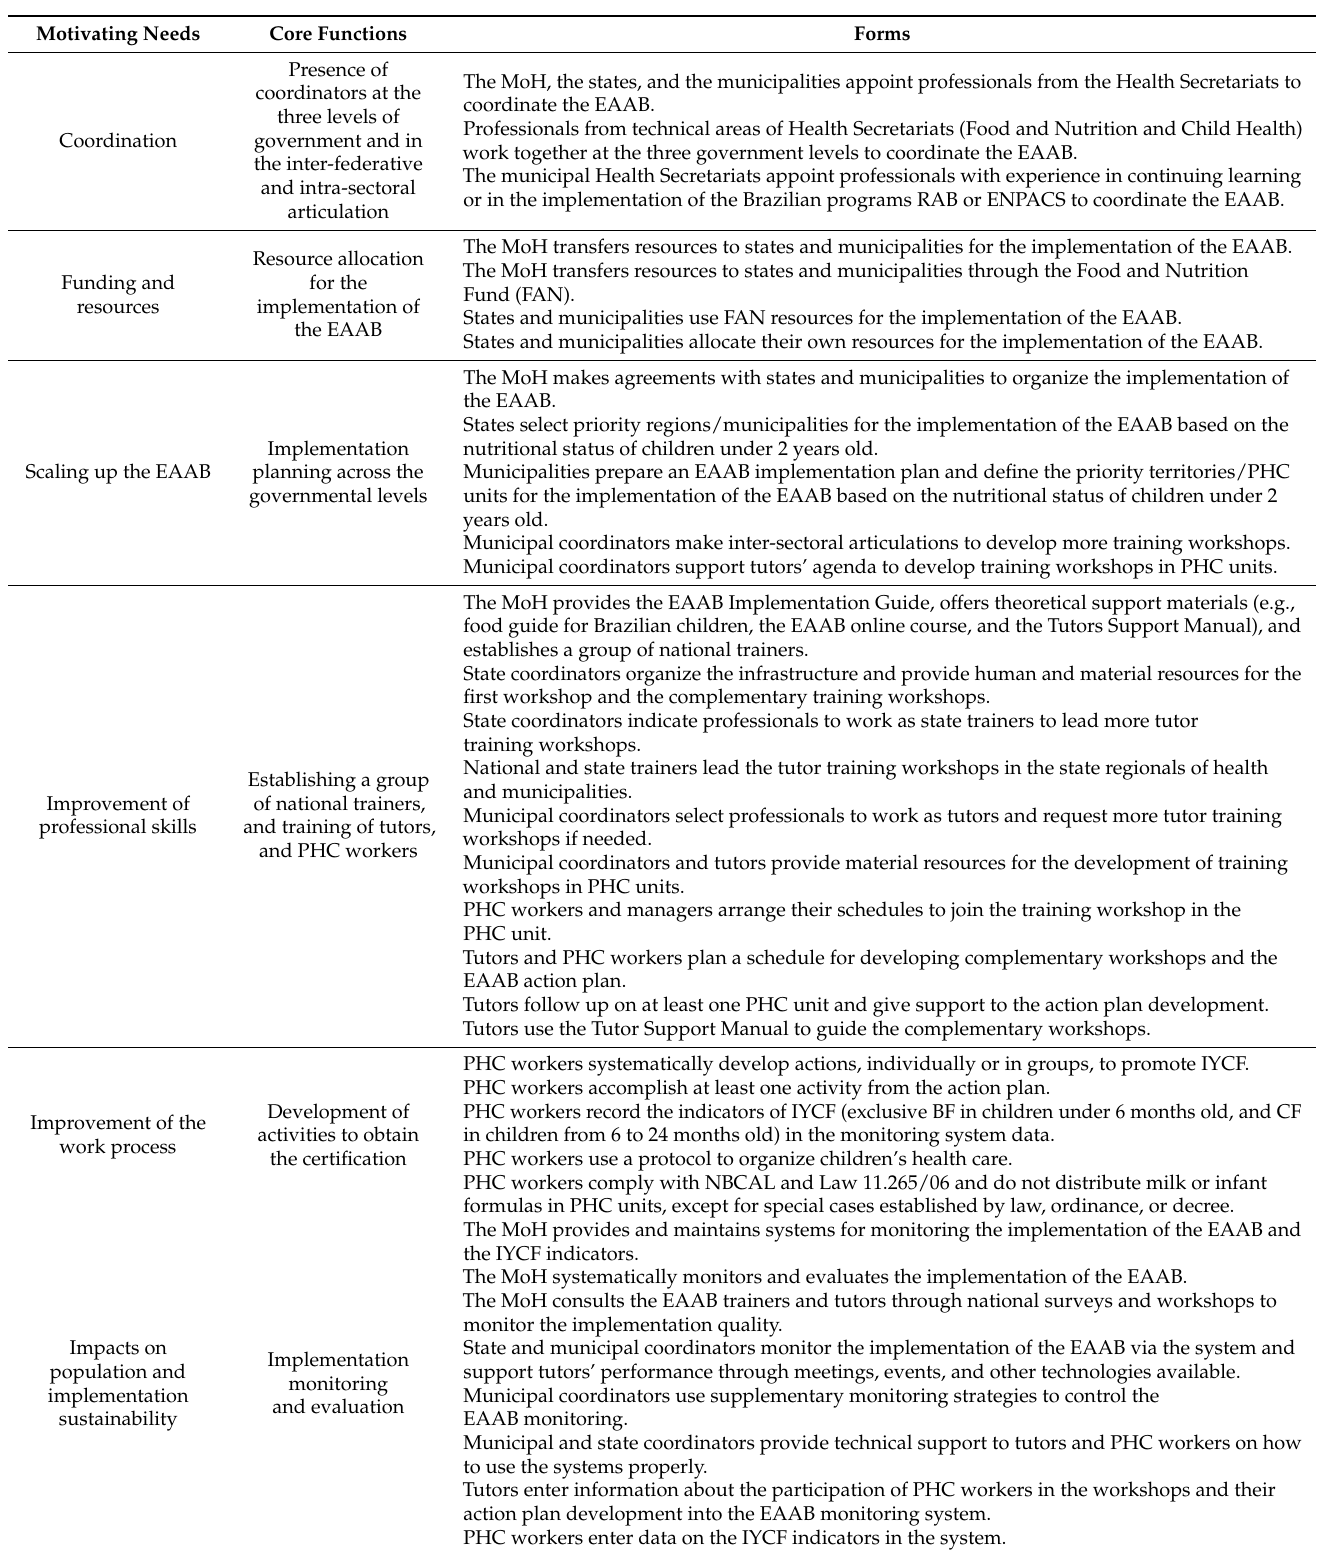
Table 4. Motivating needs, Core Functions, and Forms for the implementation of the